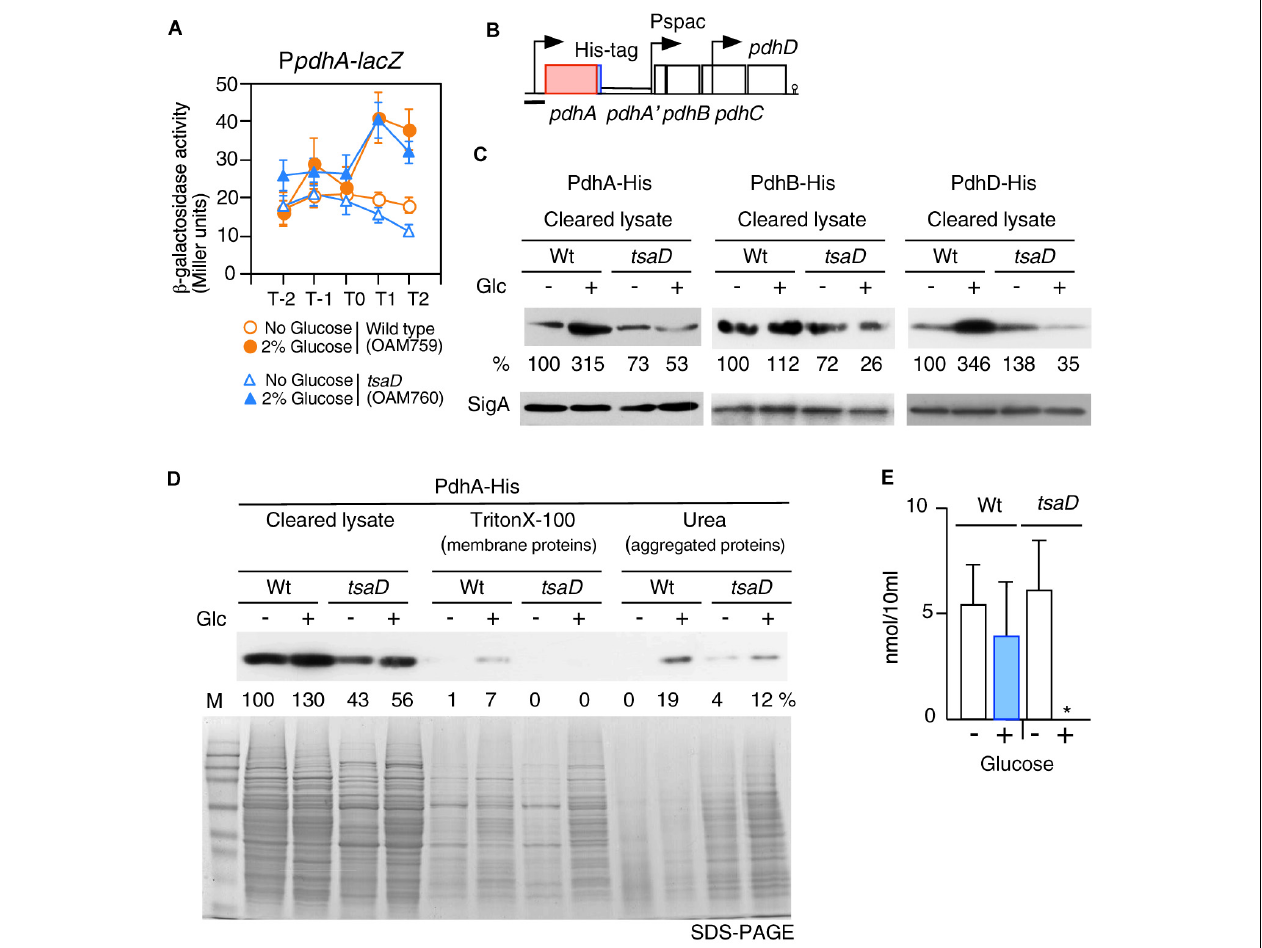
FIGURE 6 | Expression of P pdhA-lacZ and measurement of soluble PDH subunits in the tsaD mutant. (A) Expression of P pdhA-lacZ. Means of the β -Gal activities from three independent experiments and the standard deviations are shown. The x axis is the same as in the legend to Figure 1 . (B) . The chromosomal structure of the strain with pdhA - His (OAM761) is shown. The legend for graphics is the same as that of Figure 3 . The black bar shows the cloned promoter region for analyzing promoter expression. The chromosomal structures of the strains bearing PdhB-His and PdhD-His are similar to that of OAM761 (not shown). (C) Western analysis of PdhA-His, PdhB-His and PdhD-His. For the culture of each strain bearing His-tagged Pdh subunit [PdhA-His, wild type (OAM761), tsaD (OAM762); PdhB-His, wild type (OAM777), tsaD (OAM778)], 1 mM IPTG was added in sporulation medium with or without 2% glucose (“Glc” means glucose addition). For the cultures of strains with PdhD-His, wild type (OAM779) and tsaD (OAM780), no IPTG was added. Equal protein amounts of soluble fractions were analyzed in western blot using anti-His-tag monoclonal antibody for detection of each His-tagged protein. As a control, SigA detected by anti-SigA antibody is shown. (D) Western blot analysis of cleared cell lysates, “membrane protein” fractions (Triton X-100 extracts), and “aggregated protein” fractions (insoluble fractions by Triton × − 100, solubilized by urea-containing buffer) from the wild type and tsaD cells for PdhA-His. OAM761 and OAM762 cells were cultivated and treated as described in the Materials and Methods. Cell mass equivalents were analyzed using both western blot and SDS-PAGE stained by Coomassie. “M” indicates molecular weights marker (Amersham full range rainbow marker). (E) Examination of cellular acetyl-CoA pool. Samples from two independent cultures (wild type, 168; tsaD , OAM734) were analyzed three times, and standard deviations are shown. ∗ indicates that the value is less than the detection limit (0.5 nmol/10 ml).